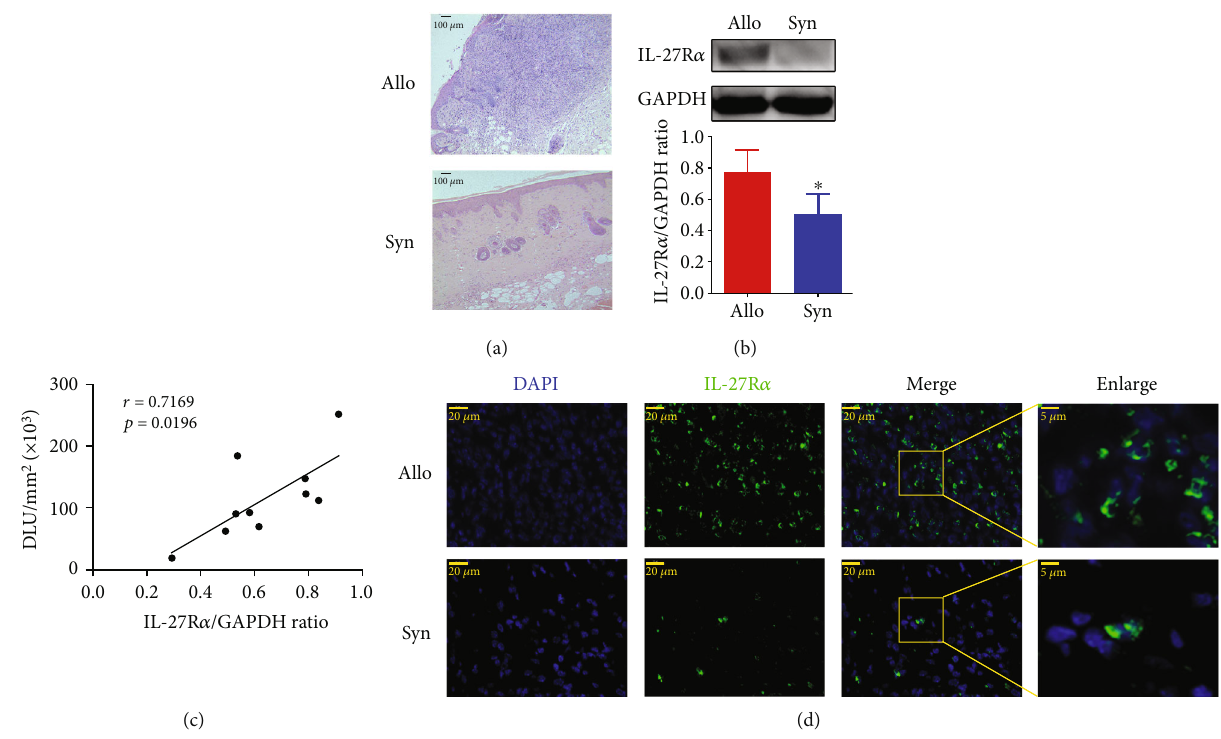
Figure 5: H&E staining and IL-27R α